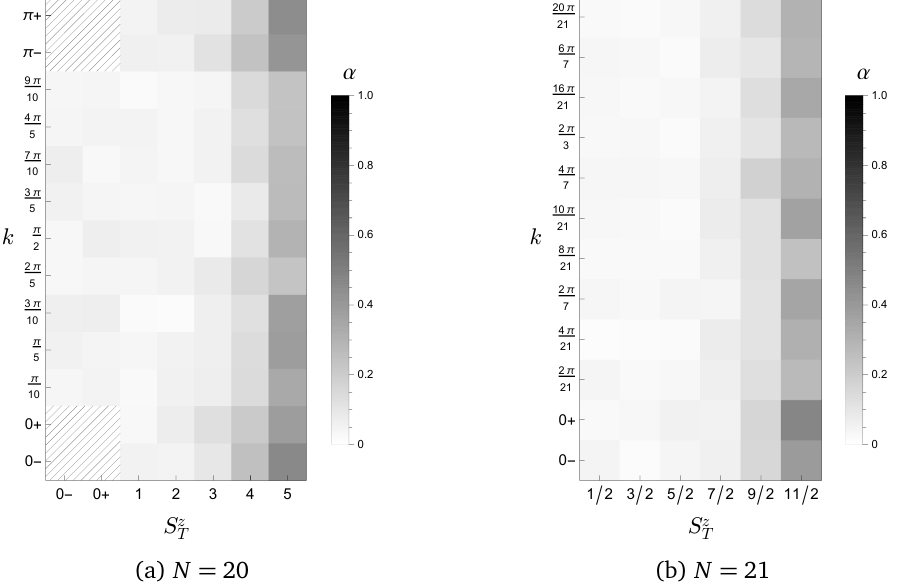
Figure 7: Fit coefficient α in each symmetry sector for N = 20 and N = 21 with κ = 0.5. Values of α = 0 and 1 correspond respectively to Wigner and Poisson dis- tributions, respectively. The symbols 0 ± and π ± on the momentum axis k designate the symmetry sectors with P = ± 1 and respectively k = 0 and π . Similarly, the 0 ± = 0. on the total z-spin axis S z designate the symmetry sectors with T = ± 1 and S z T T ≥ 6 are not shown as they are Here T corresponds to time-reversal. Sectors with S z T too small ( < 300) to produce a good